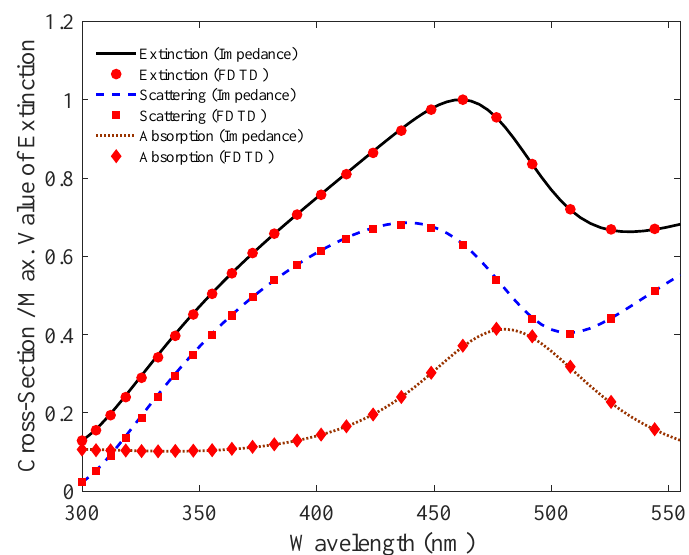
Figure 8. TM mode: Comparison of Q ext , Q sca and Q abs simulation for a 40 nm radius cylindrical nanowire using our proposed impedance model with the full-wave field solver. The values are normalized to unity for the extinction cross-section efficiency, with scattering and absorption plot scaled accordingly. The simulation result show negligible difference between the two models.